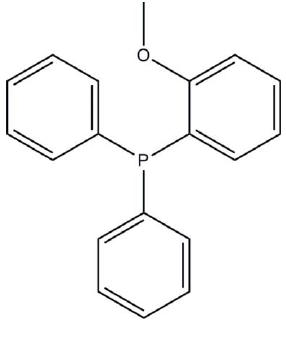
Experimental Crystal data